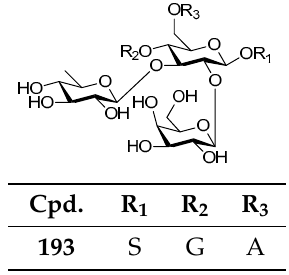
Figure 26. Structures of compounds 188 – 192 .